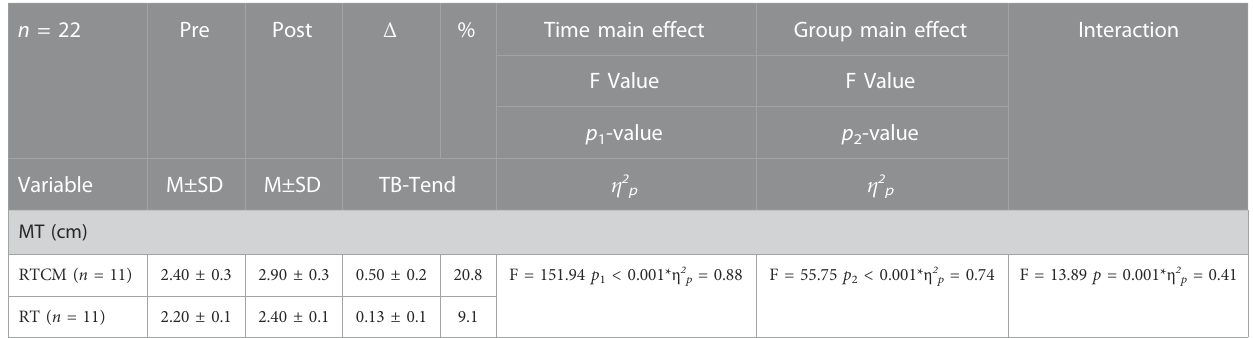
TABLE 2 MT measurements analyzed using ultrasonography of the vastus lateral is muscles pre and